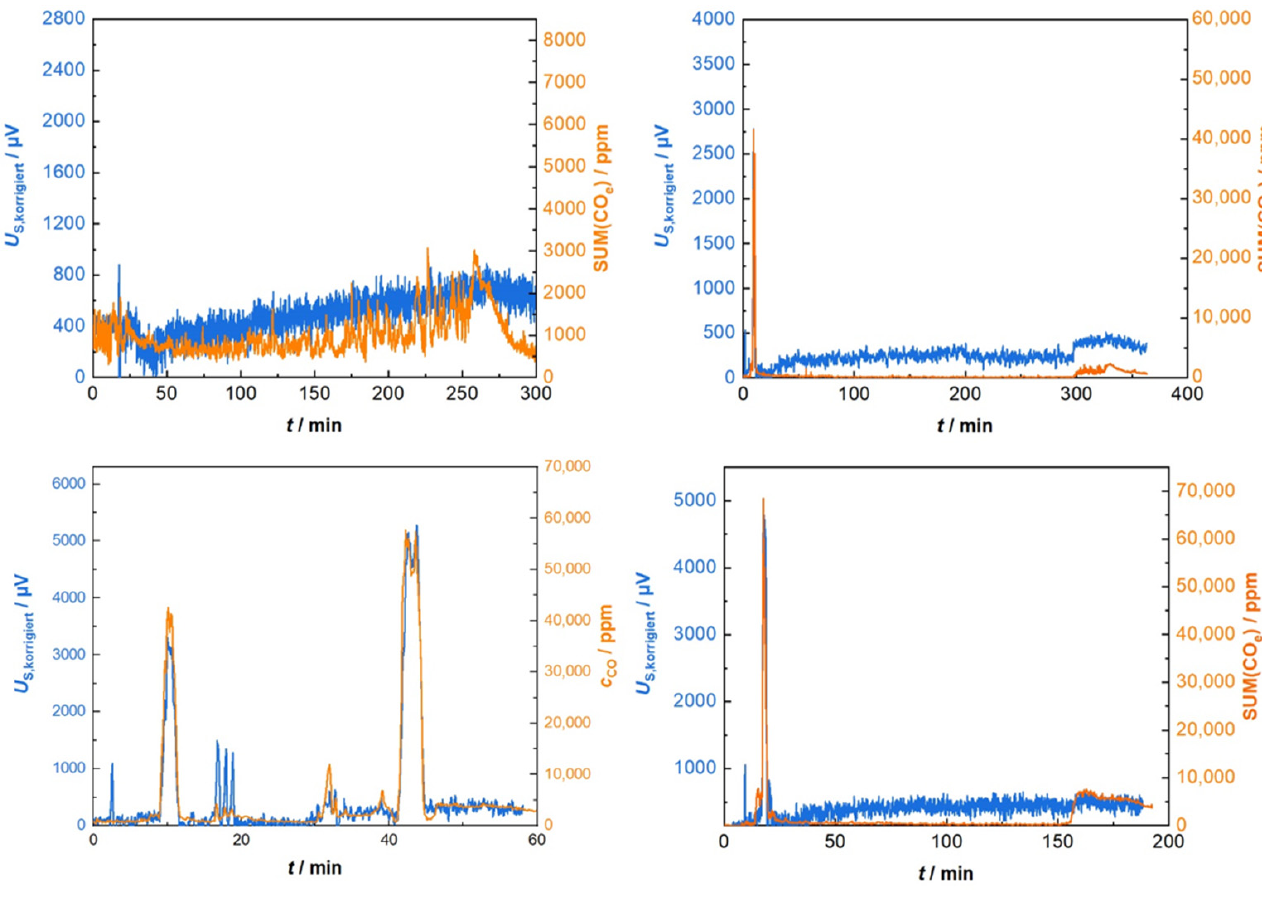
Figure 11. Sensor performance (Gen_2) when it was applied to a continuously operated biomass boiler (DBFZ, Leipzig). Heating power was corrected once before for all measurements. The sensor measures single peaks of emissions precisely up to 70,000 ppm.